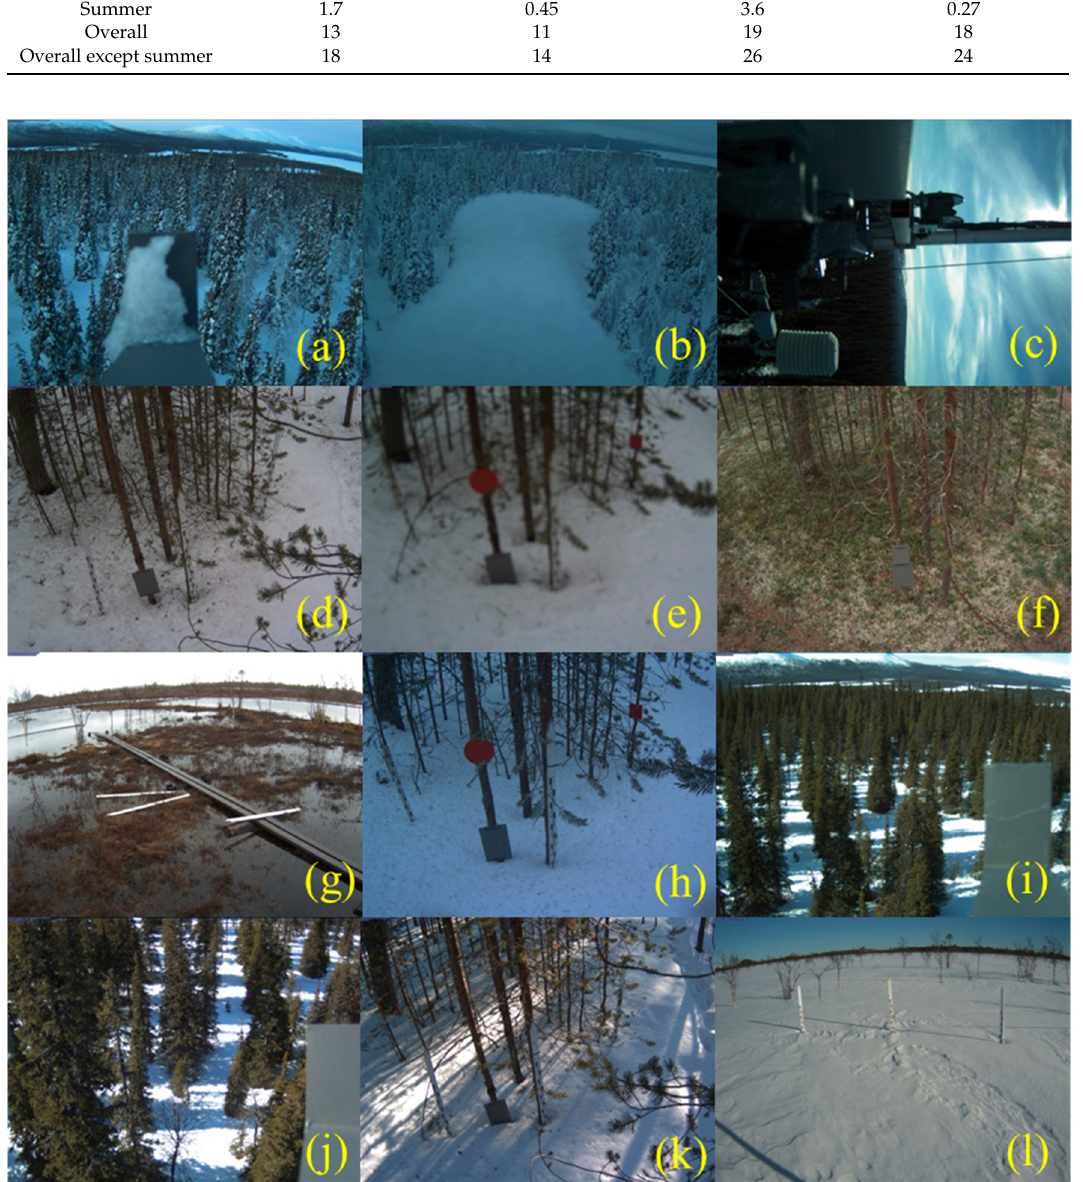
Figure 15. Problems in the images that cause failures in detection of fractional snow cover: ( a ) Field of view blocked by the reference plate after the camera movement; ( b ) Field of view blocked by the accumulation of snow on reference plate; ( c ) Field of view loss after the camera movement; ( d , e ) Before and after the minimal camera movement and loss of focus; ( f ) Lichen on the ground; ( g ) Water accumulation which reflects the bright sky and fallen snow sticks; ( h ) Litter and dirt on the ground; ( i ) Shadow of trees in Kenttärova canopy camera field of view; ( j ) Shadow of trees in Kenttärova ground camera field of view; ( k ) Shadow by trees and snow sticks in Sodankylä ground camera field of view; ( l ) Shadow by the snow surface irregularites, snow roughness, snow sticks, and camera mast.